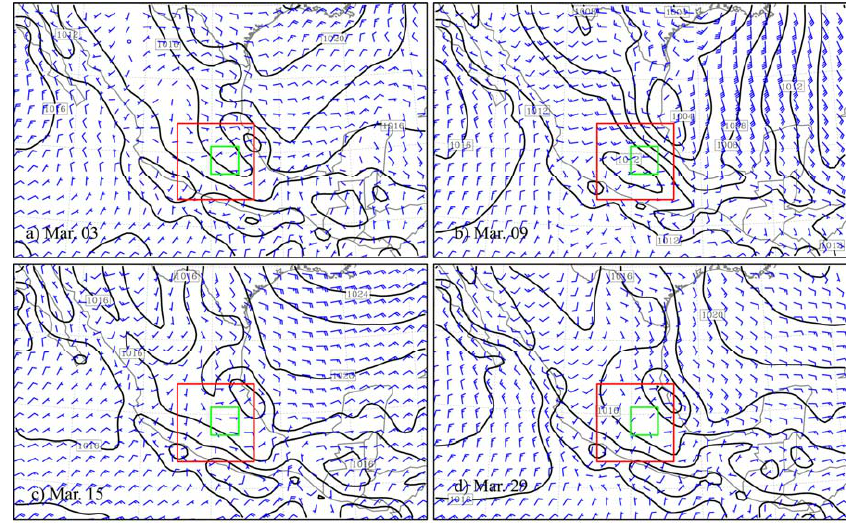
Fig. 4. Same as in Fig. 3, but for surface pressure and